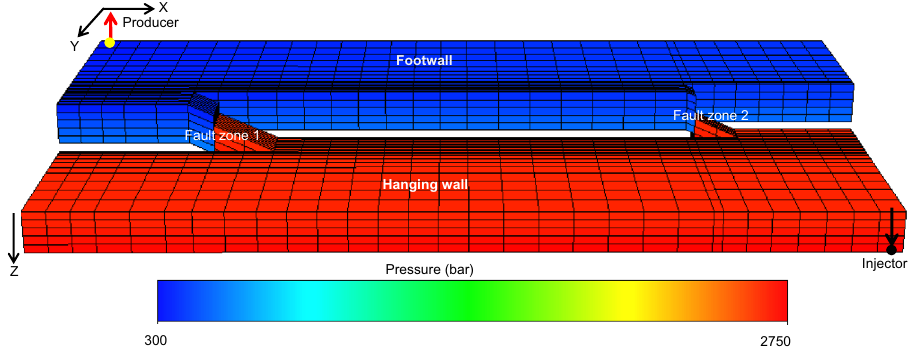
Figure 4. The pressure distribution in the truth model at water breakthrough time obtained from single-phase flow simulation using the well locations